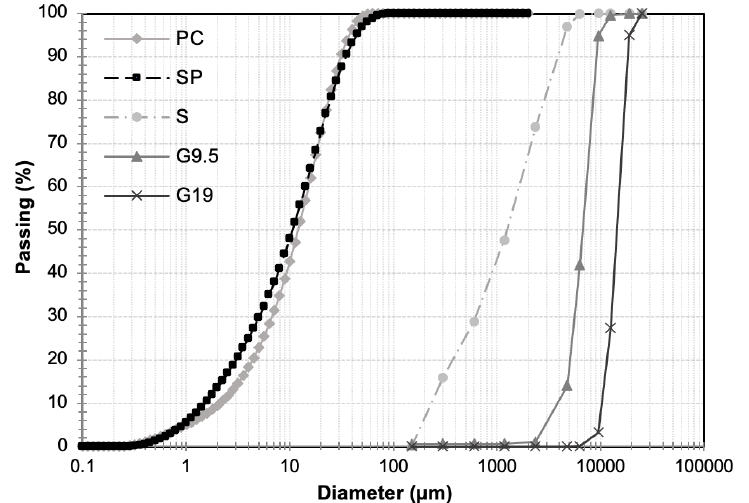
Figure 1. Particle size distribution of the materials.